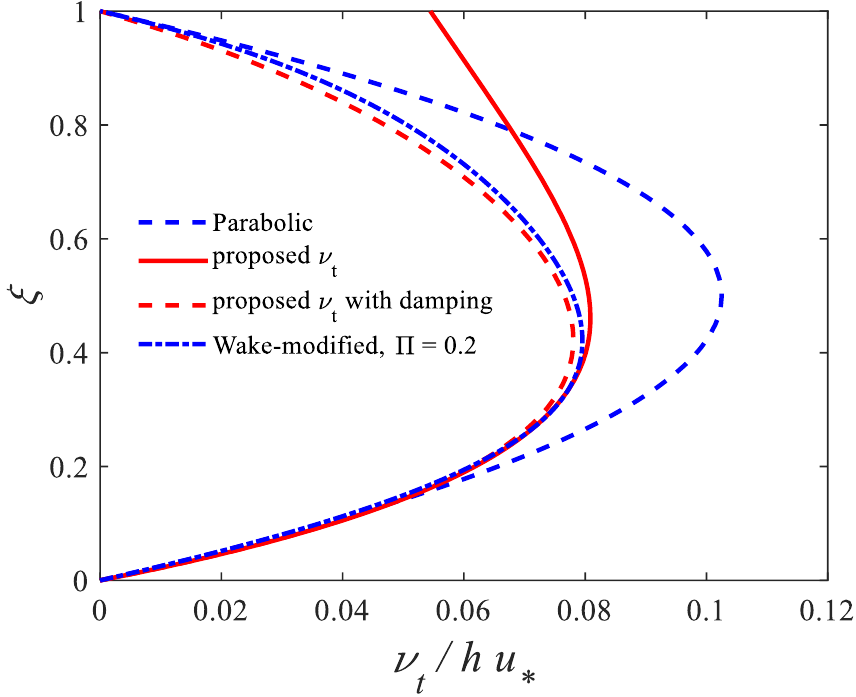
Figure 4. Eddy viscosity profiles in open-channel flows; red solid line: eddy viscosity (Equation (2)) with C α = 0.477 and C 1 = 2.17; red dashed line: eddy viscosity with free surface damping function (Equation (3)) with B f = 6; blue dashed line: parabolic eddy viscosity; blue dash-dotted line: log-wake-modified with Π = 0.2 [61].